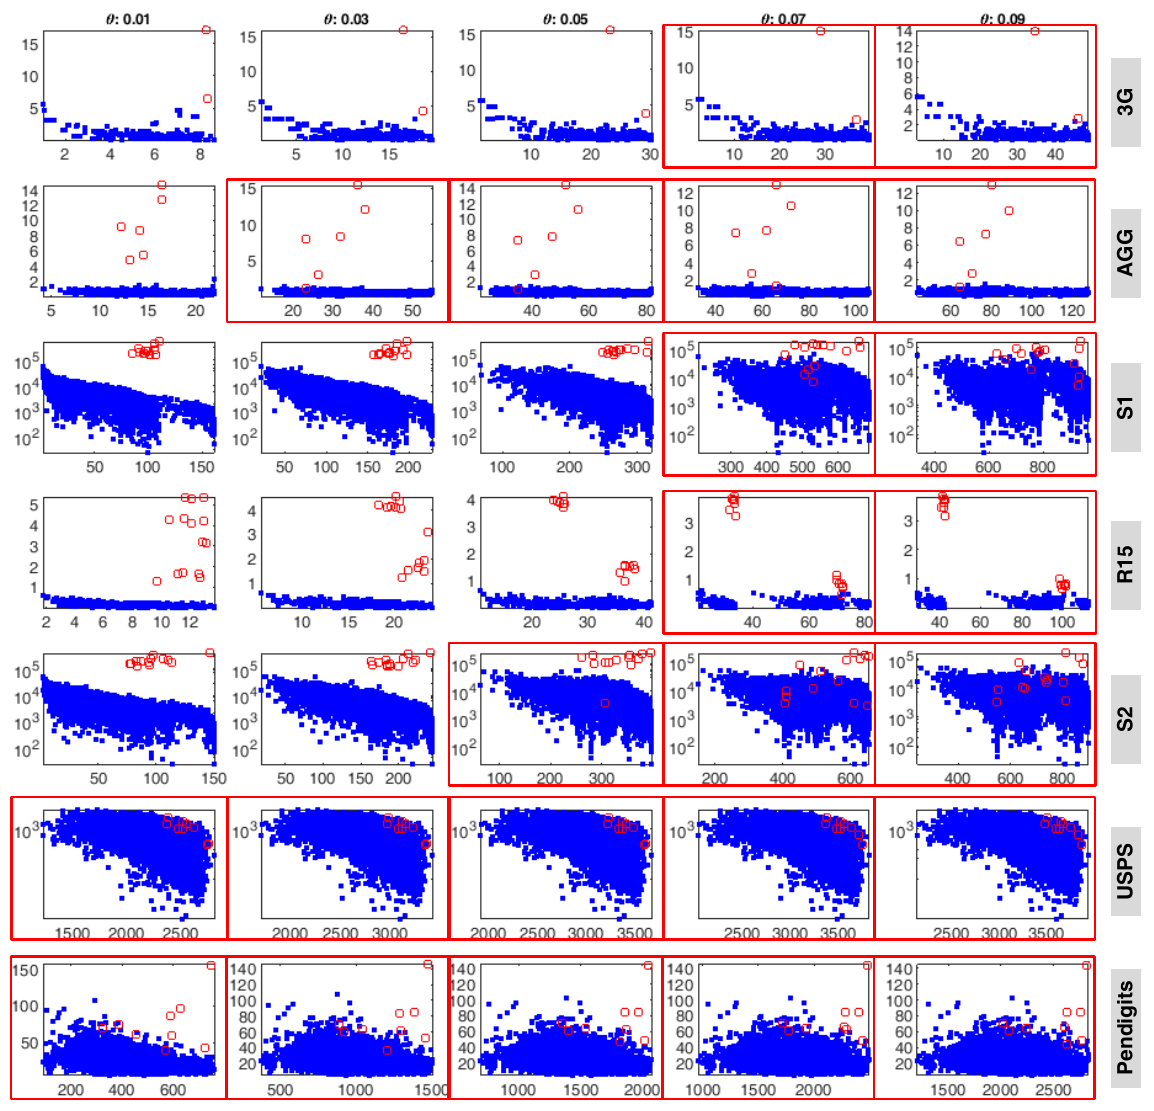
Figure 15. The 2-classification Decision Diagrams of ND-C(3) with different values of θ on different datasets. From top to bottom, the test datasets are 3G, AGG, S1, R15, S2, USPS, and Pendigits, respectively. From left to right, the values of θ of ND-C(3) are 0.01, 0.03, 0.05, 0.07, and 0.09, respectively. The red rectangles mark the 2-classification Decision Diagrams in which there exist the red circles that are not well separated with the blue ones.